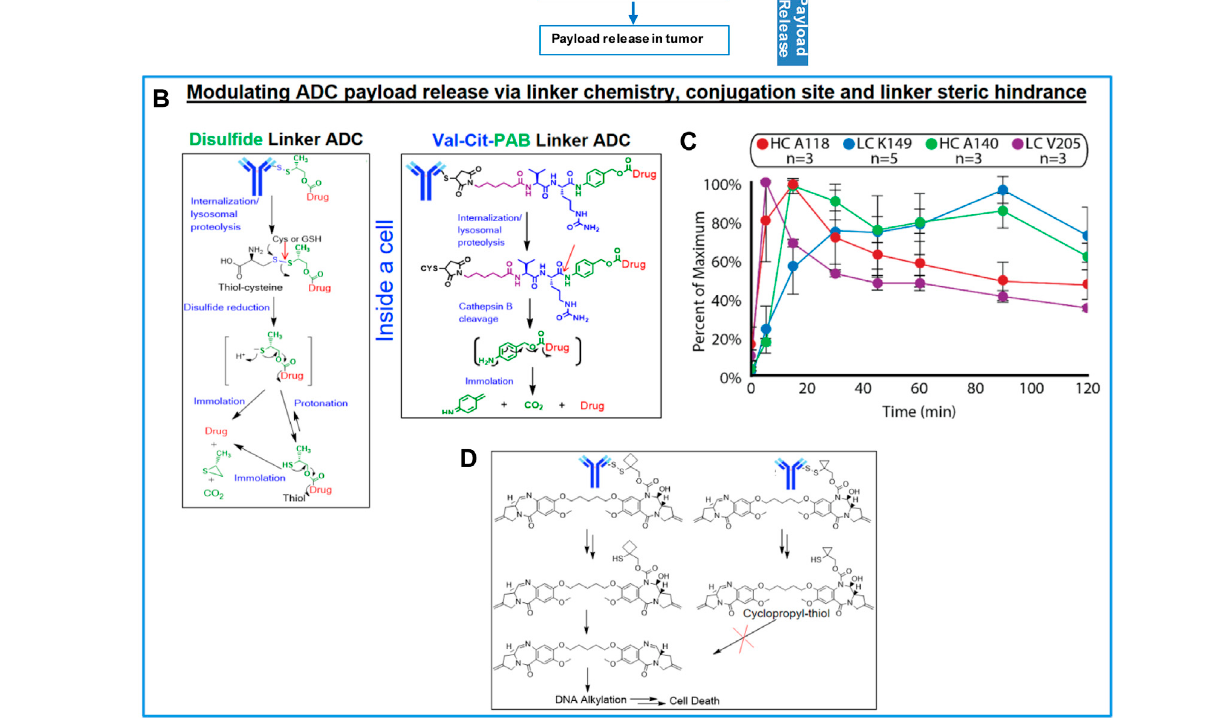
Frontiers in Pharmacology |